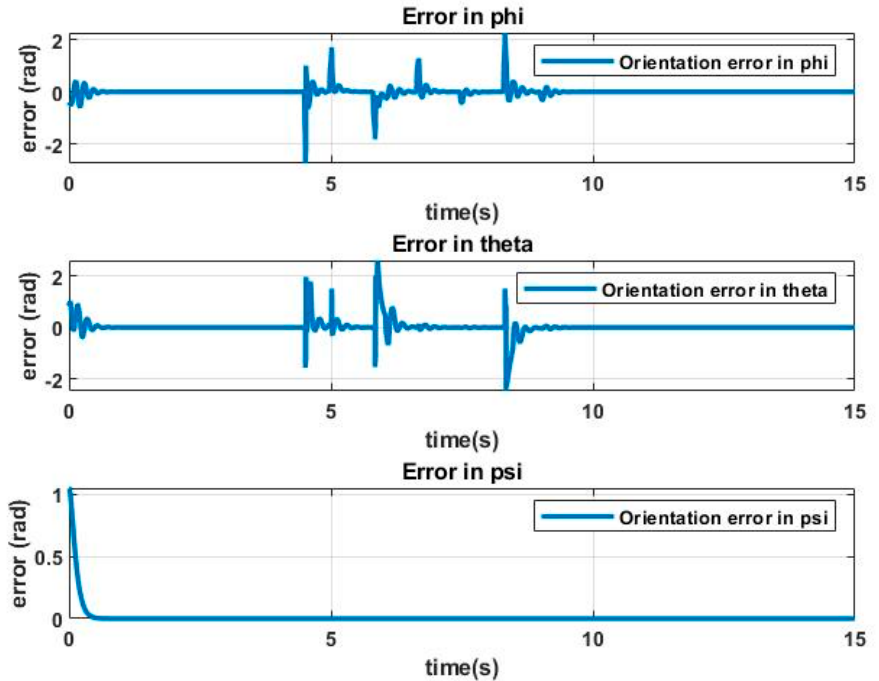
Figure 19. Relative orientation errors vs. time from task with perturbance.